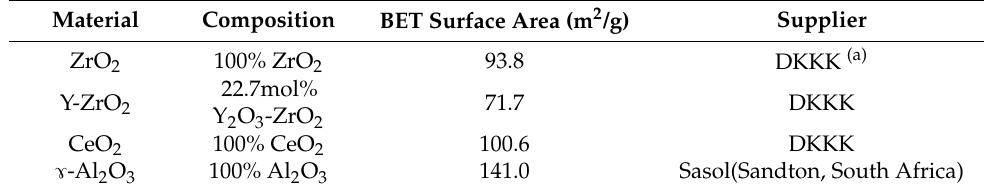
Table 3. Properties of the catalyst support materials.